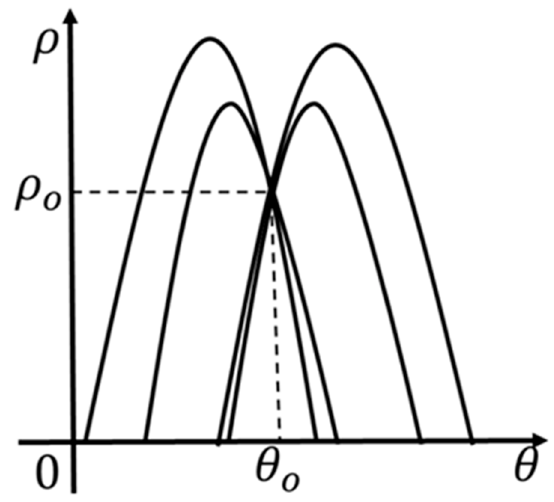
Figure 9. (x, y) space to ( 𝑟,𝜃 ) space conversion. Figure 9. ( x , y ) space to ( r , θ ) space conversion.